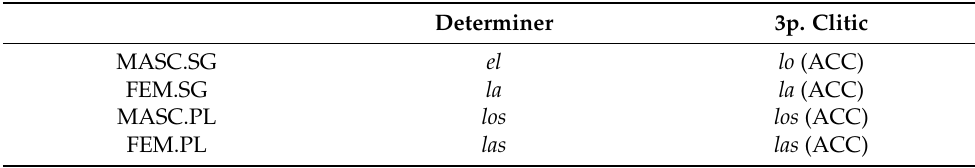
Table 1. Parallelism between determiners and